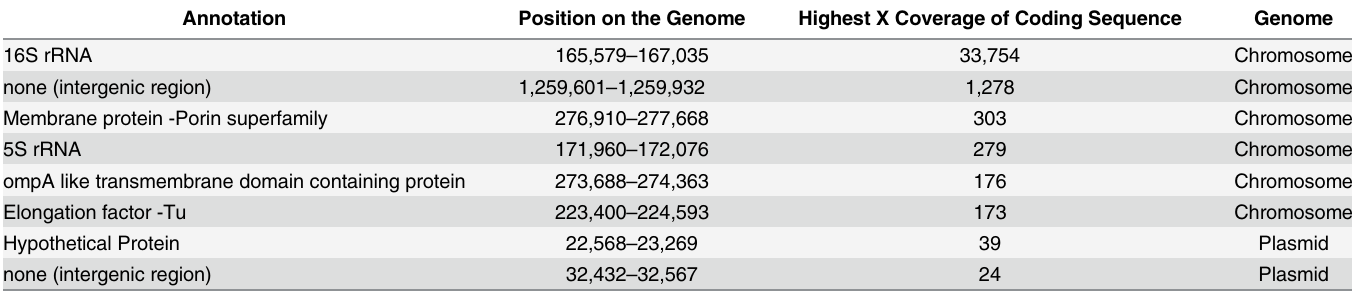
Table 2. List of the highest coverage regions in Coxiella burnetii RSA 493 chromosome and Coxiella burnetii RSA 493 plasmid pQpH1 found in sample